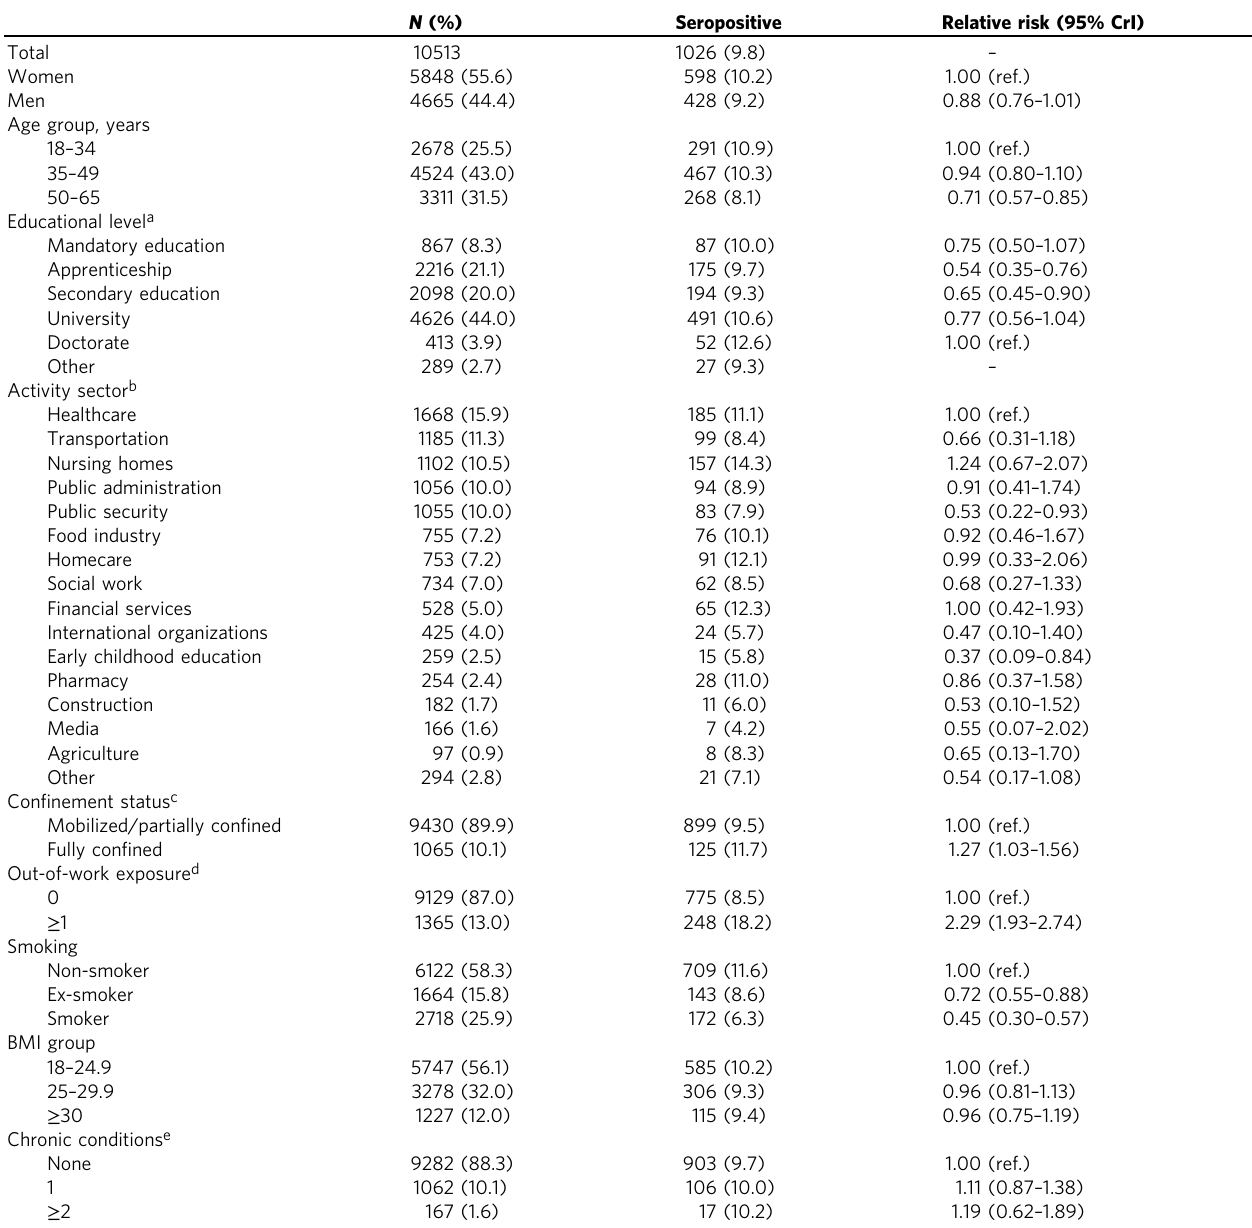
Table 1 Sample description and prevalence of anti-SARS-CoV-2 IgG antibodies, SEROCoV-WORK + study, May – September 2020, Geneva,